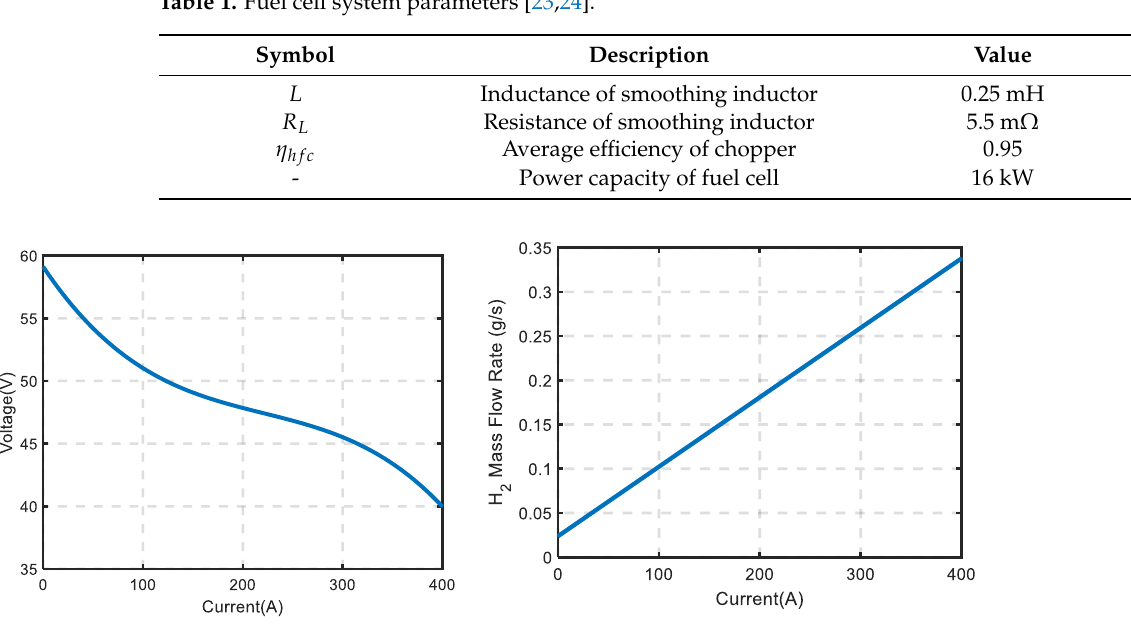
Table 1. Fuel cell system parameters [23,24].